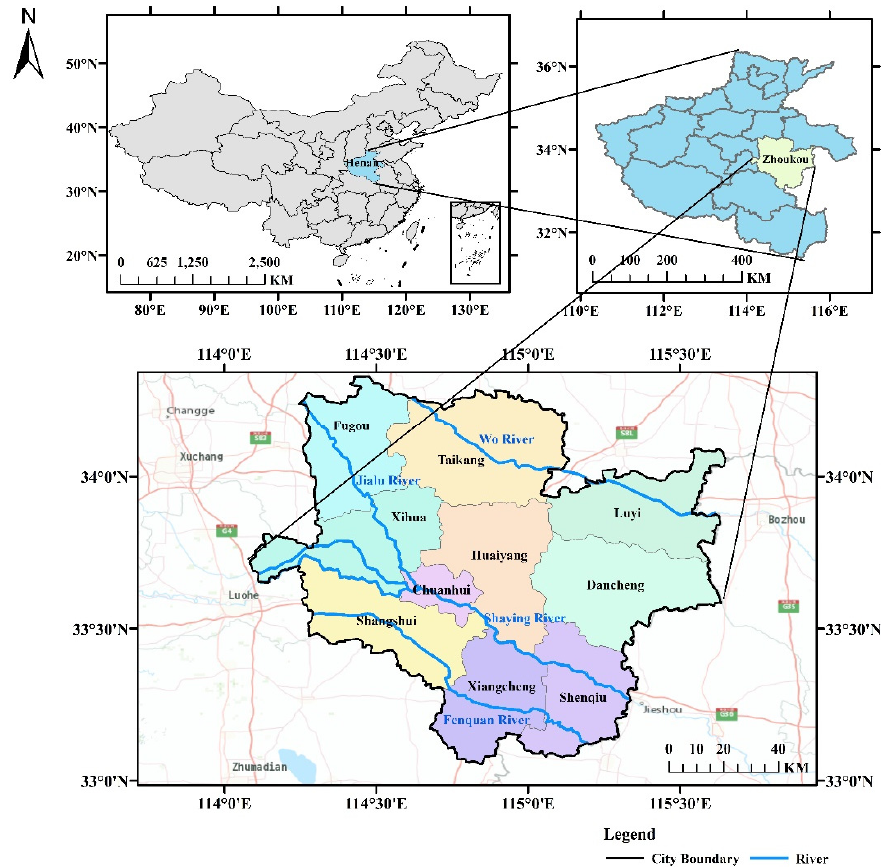
Figure 1. Zhoukou city location map.